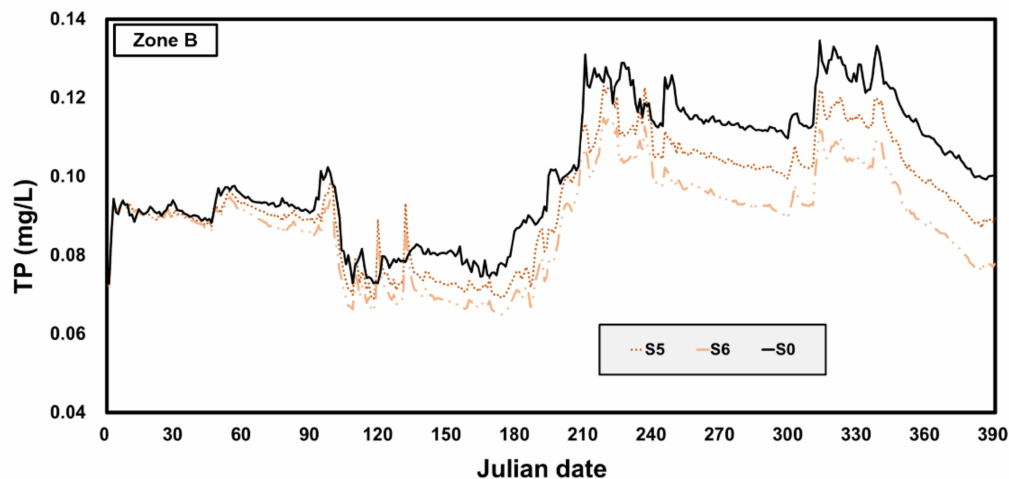
Figure 12. Simulated results of T-P concentration (Zone B, S0, S5–S6).